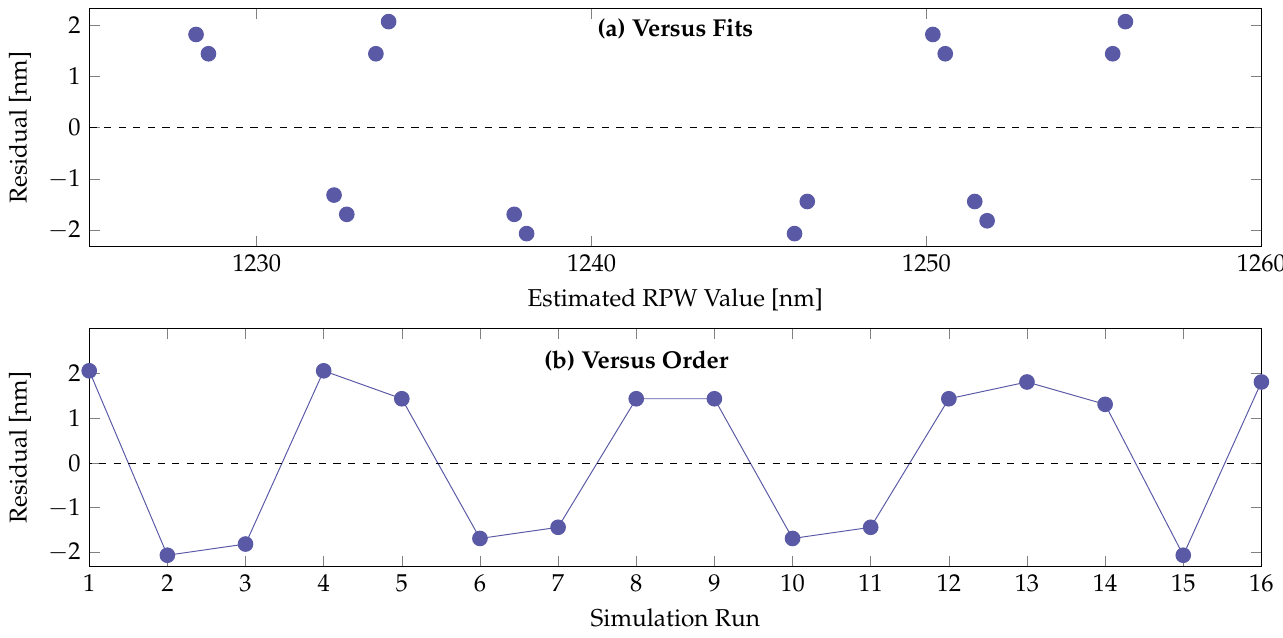
Figure 5. Residual analysis plots of the factorial design model for RPW: ( a ) Residual versus estimated RPW value scatter diagram and ( b ) Residual versus Simulation run scatter